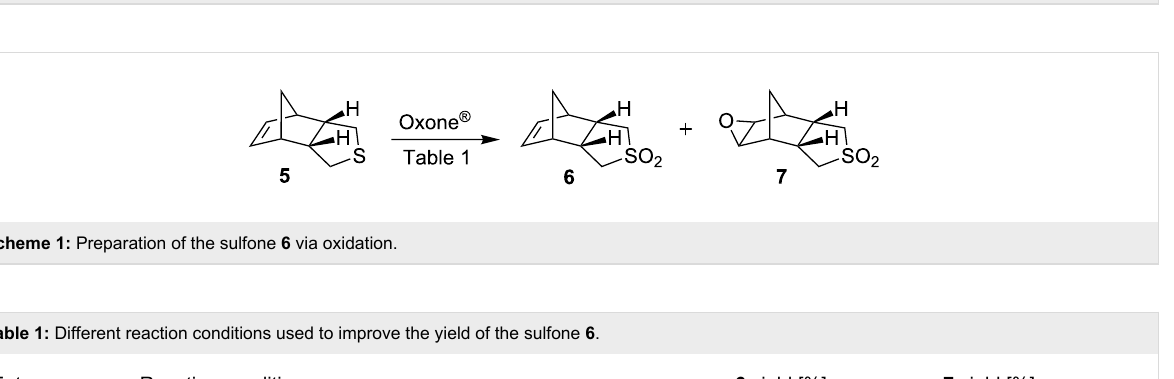
Figure 1: Retrosynthetic approach to polycyclic sulfones.